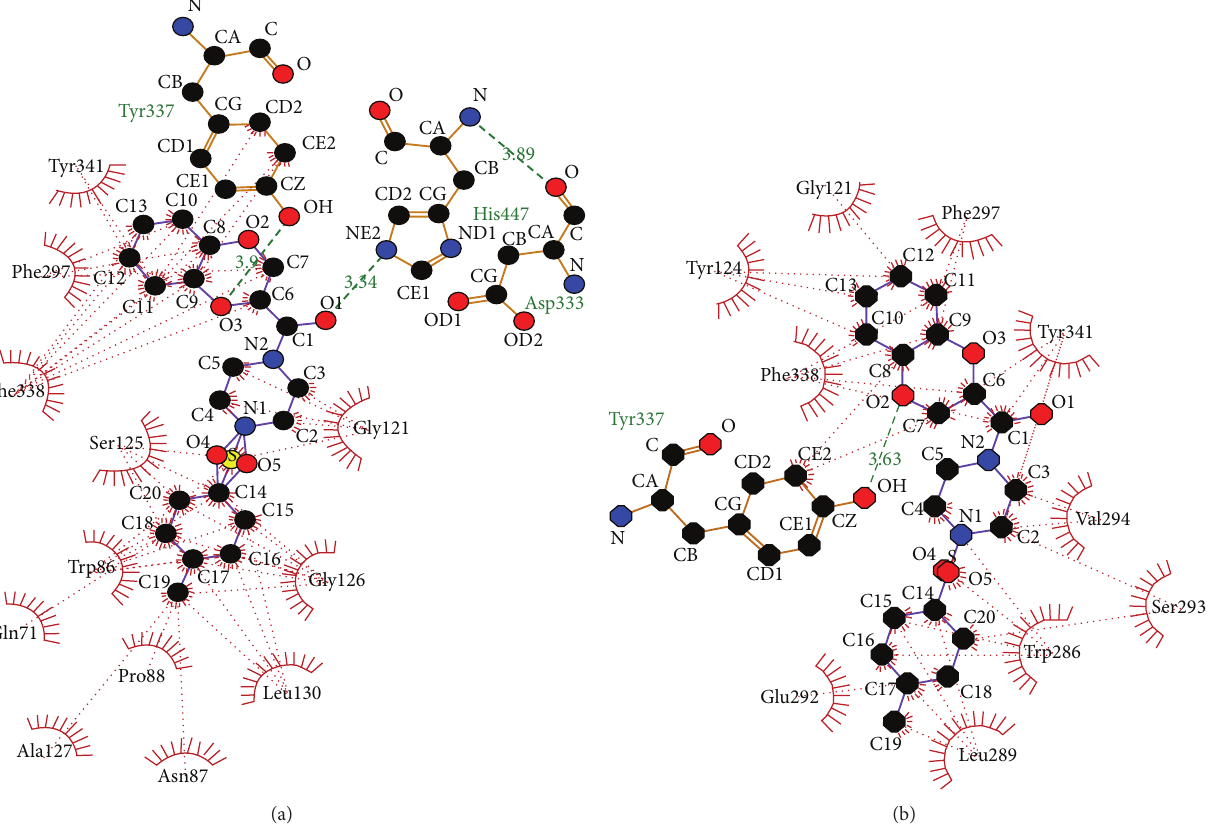
Figure 4: (a) Catalytic site docking of 4-(4-methyl)-benzenesulfonyl-1-(1,4-benzodioxane-2-carbonyl) piperazine (S1). (b) Peripheral anionic site docking of 4-(4-methyl)-benzenesulfonyl-1-(1,4-benzodioxane-2-carbonyl) piperazine